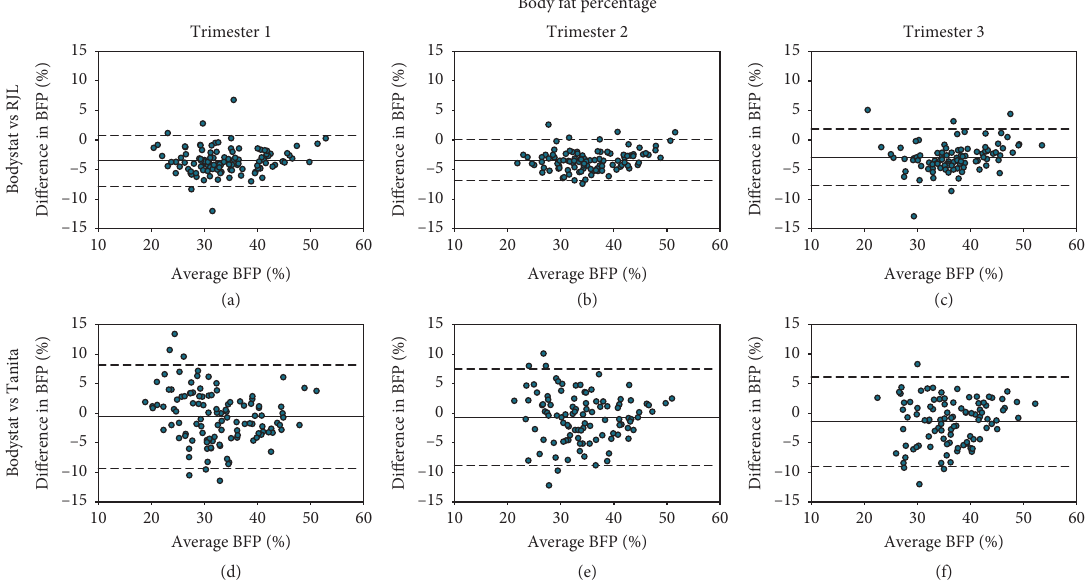
Figure 1: Bland–Altman plots of the differences of BFP against average BFP between two methods: (a–c) Bodystat vs. RJL and (d–f) Bodystat vs. Tanita. Differences in BFP are calculated as Bodystat minus comparison method (RJL or Tanita). BFP: body fat